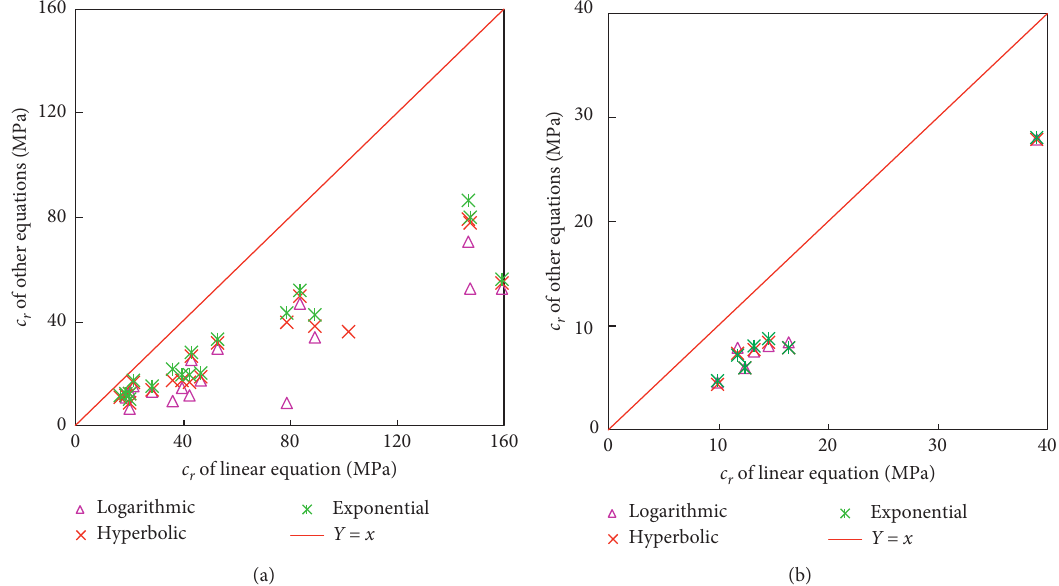
t ) t is not included in regression. (b) ( σ t ) t is included in regression.